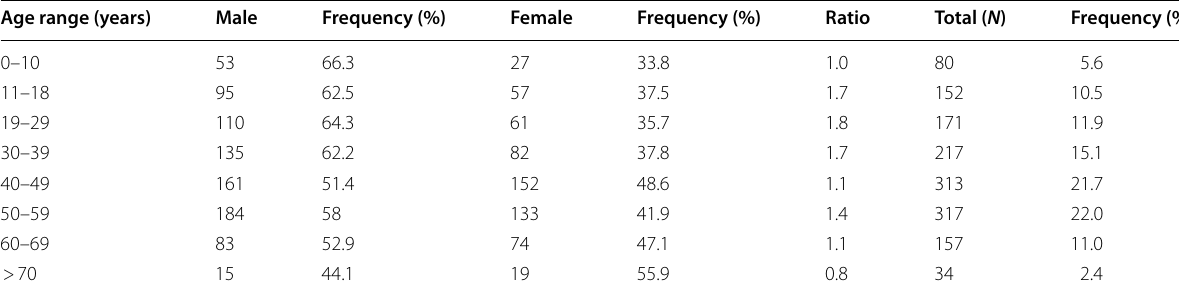
Table 2 Age and gender wise distribution of primary brain and other CNS tumors from 1996 to 2022 Age range (years)